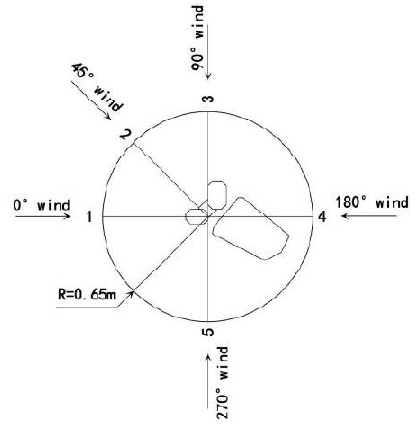
Figure 4. Measurement point layout.